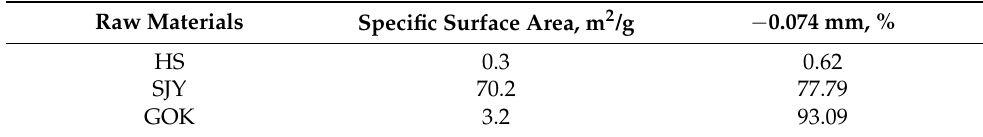
Table 3. Size properties of experimental raw materials.